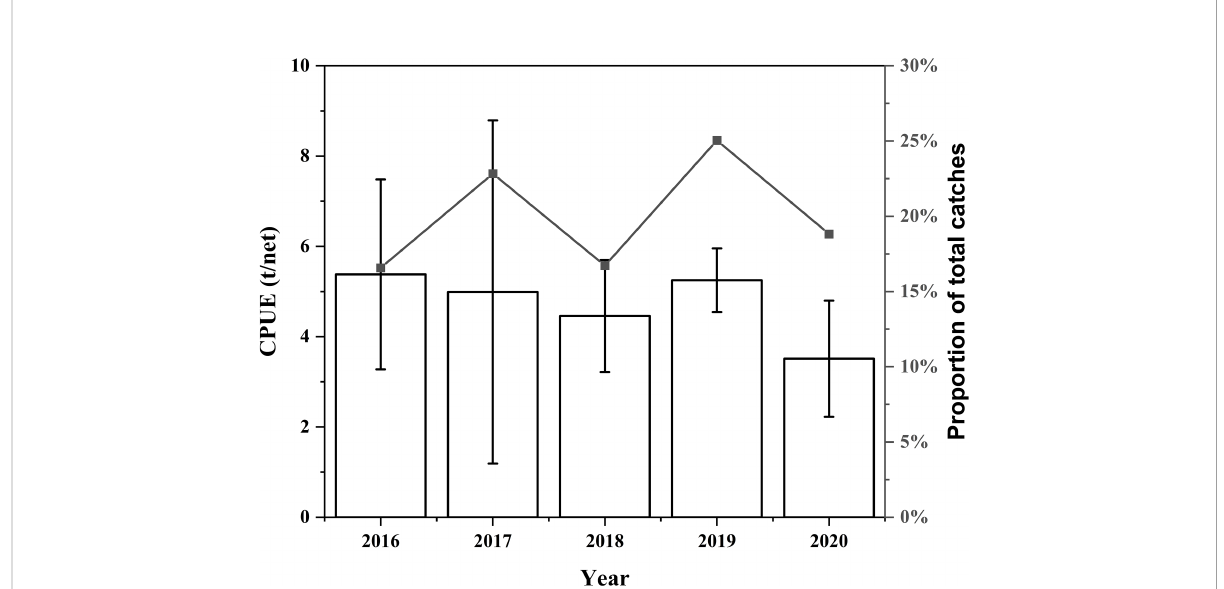
FIGURE 2 Variation in the proportion of total catches (line) and CPUE (bar) of light falling gear in the Northwest Indian Ocean on a yearly scale (mean ± standard deviation).